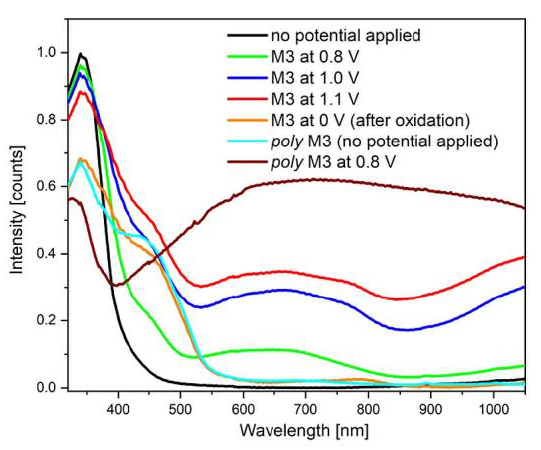
Figure 9. UV-Vis spectroelectrochemistry of the M3 derivative in chloroform solution (c = 1 × 10 − 4 mol/L, as an inset on the graph potentials vs. Fc/Fc + redox couple).